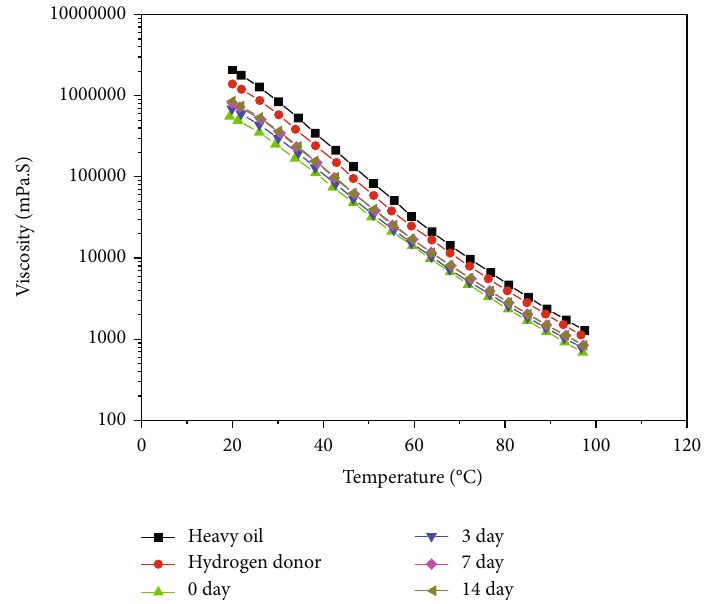
Figure 8: Viscosity-temperature curves of heavy oil obtained from each group of experiments.